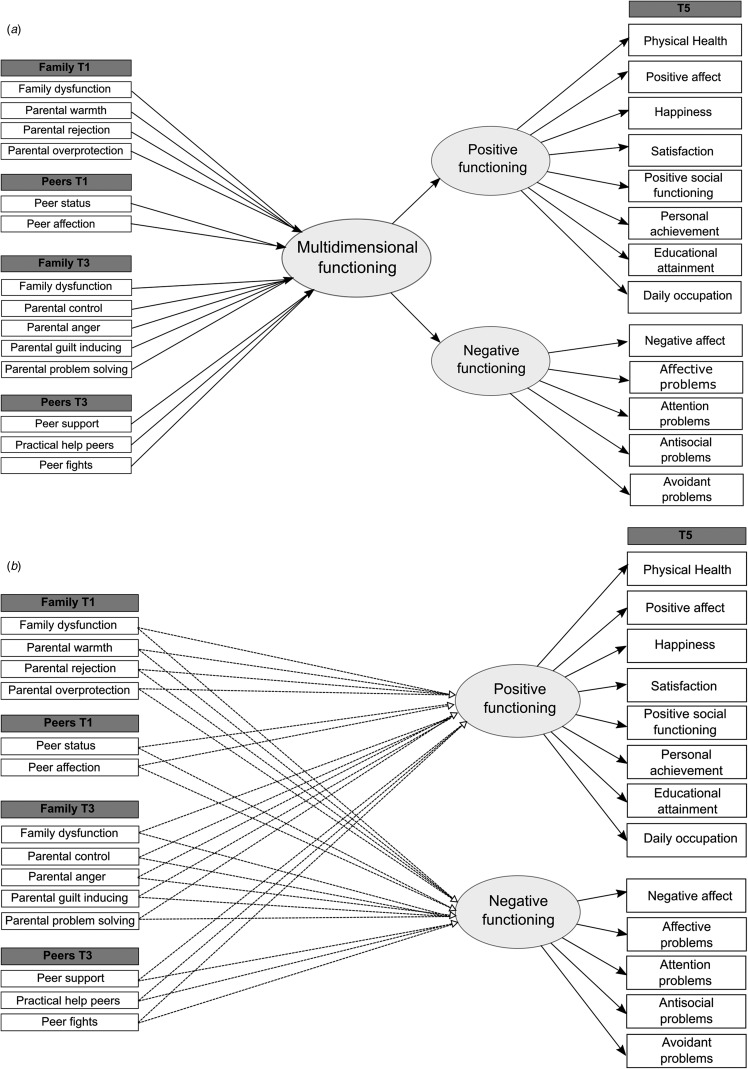
Schematic overview of the structural equation models assessing effects of the social environment on the second-order latent variable multidimensional functioning (a) and the two first-order latent variables positive and negative functioning (b). For ease of interpretation, cross-sectional and longitudinal interaction effects between family and peer environments were omitted.